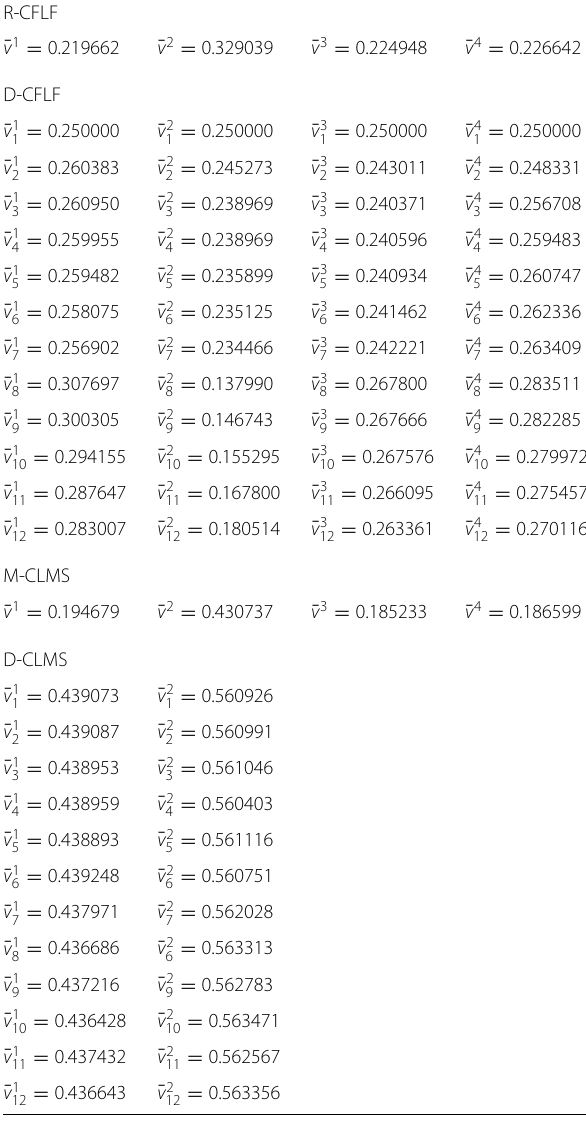
Table 6 Comparison of time-averaged mixing coefficients under stationary